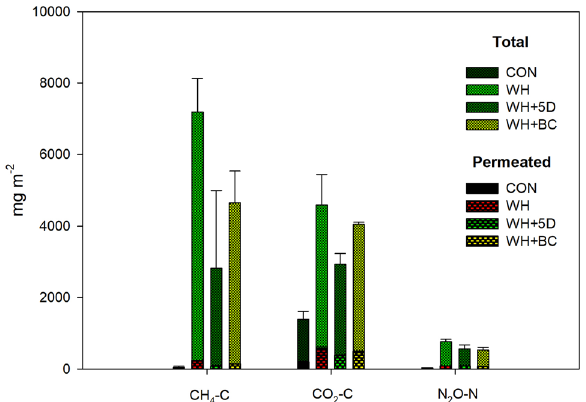
Figure 7. The cumulative emissions (mg m −2 ) of CH 4 , CO 2 and N 2 O from different amendments during BSD treatment period. Bars with dash-filled pattern were the cumulative emissions of gases permeated through the cover film. CON: soil without any amendments; WH: soil amended with wheat straw; WH + 5D: soil amended with wheat straw 5 days before the BSD treatment; WH + BC: soil amended with wheat straw and